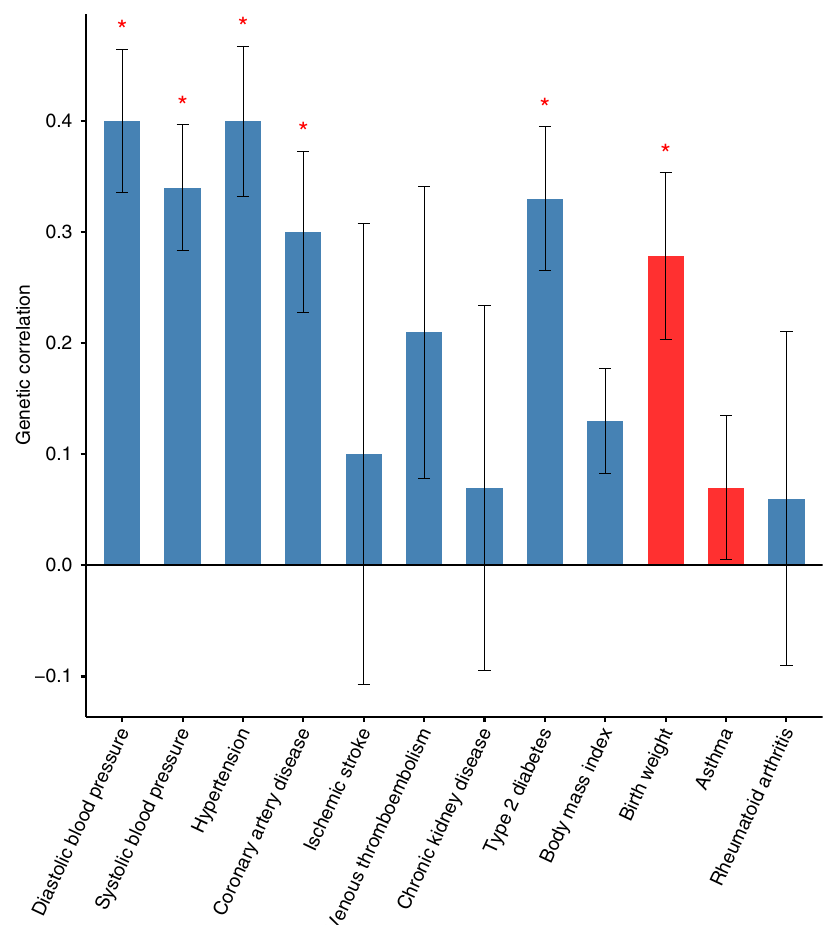
Fig. 2 Genetic correlation between maternal preeclampsia and selected traits. Genetic correlation between pairs of traits using the cross-trait LD-score regression method in the European maternal preeclampsia data sets and the summary statistics from deCODE and UK Biobank data sets for each secondary trait. On one hand, we calculated the genetic correlation between preeclampsia meta-analysis of GOPEC, ALSPAC, and MoBa data, and deCODE GWAS summary statistic for each secondary trait, and on the other hand between preeclampsia meta-analysis of deCODE, SSI, and FINRISK data, and UK Biobank GWAS summary statistic for each secondary trait. The P -values and genetic correlation estimates presented are the meta-analysis of the two independent tests, with the exception of birth weight of fi rst child where the results only include the preeclampsia meta-analysis excluding UK data sets and the UK biobank data on birth weight of the fi rst child. The height of the bars indicates the genetic correlation, blue bars indicate a positive correlation, red bars indicate a negative correlation. Error bars indicate standard error. Red asterisks indicate results that are signi fi cant after accounting for the 12 traits tested. Signi fi cance threshold: P = 0.05/12 = 0.0042. Details of the results presented in the fi gure are reported in Supplementary Table